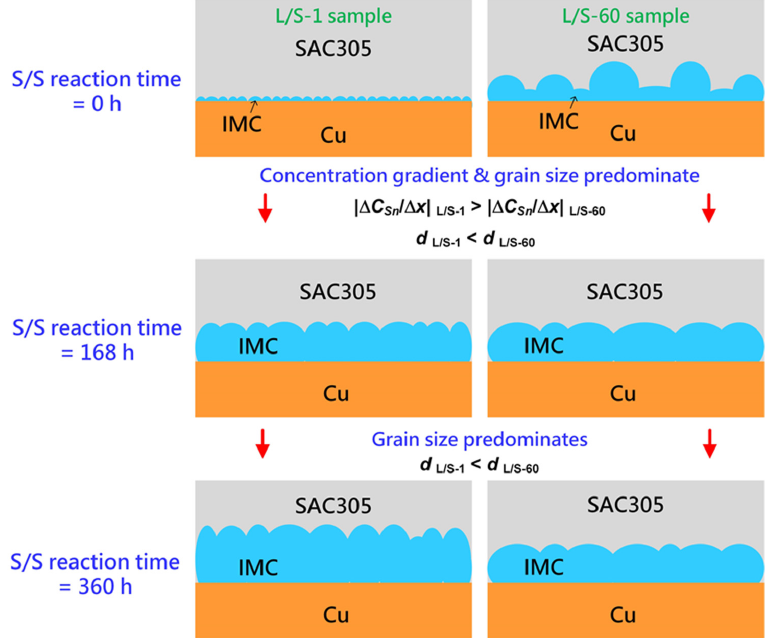
Figure 10. Schematic drawing of the IMC growth behavior in the L/S-1 and L/S-60 samples subjected to the S/S reactions.